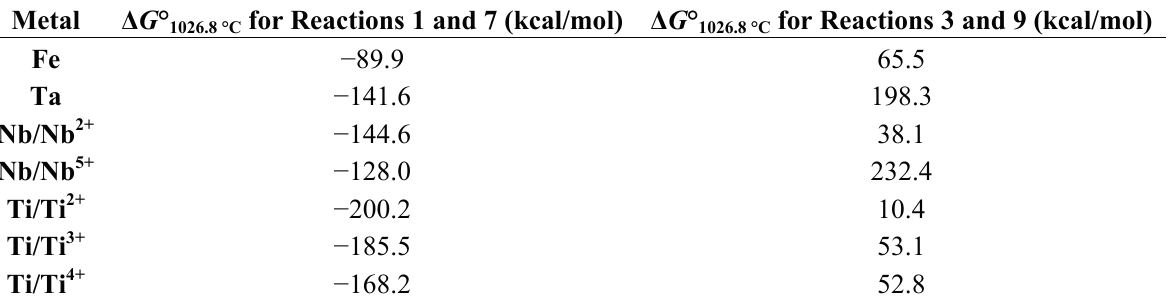
Table 2. Δ G ° for reactions 1, 3, 7, and 9 1026.8 °C